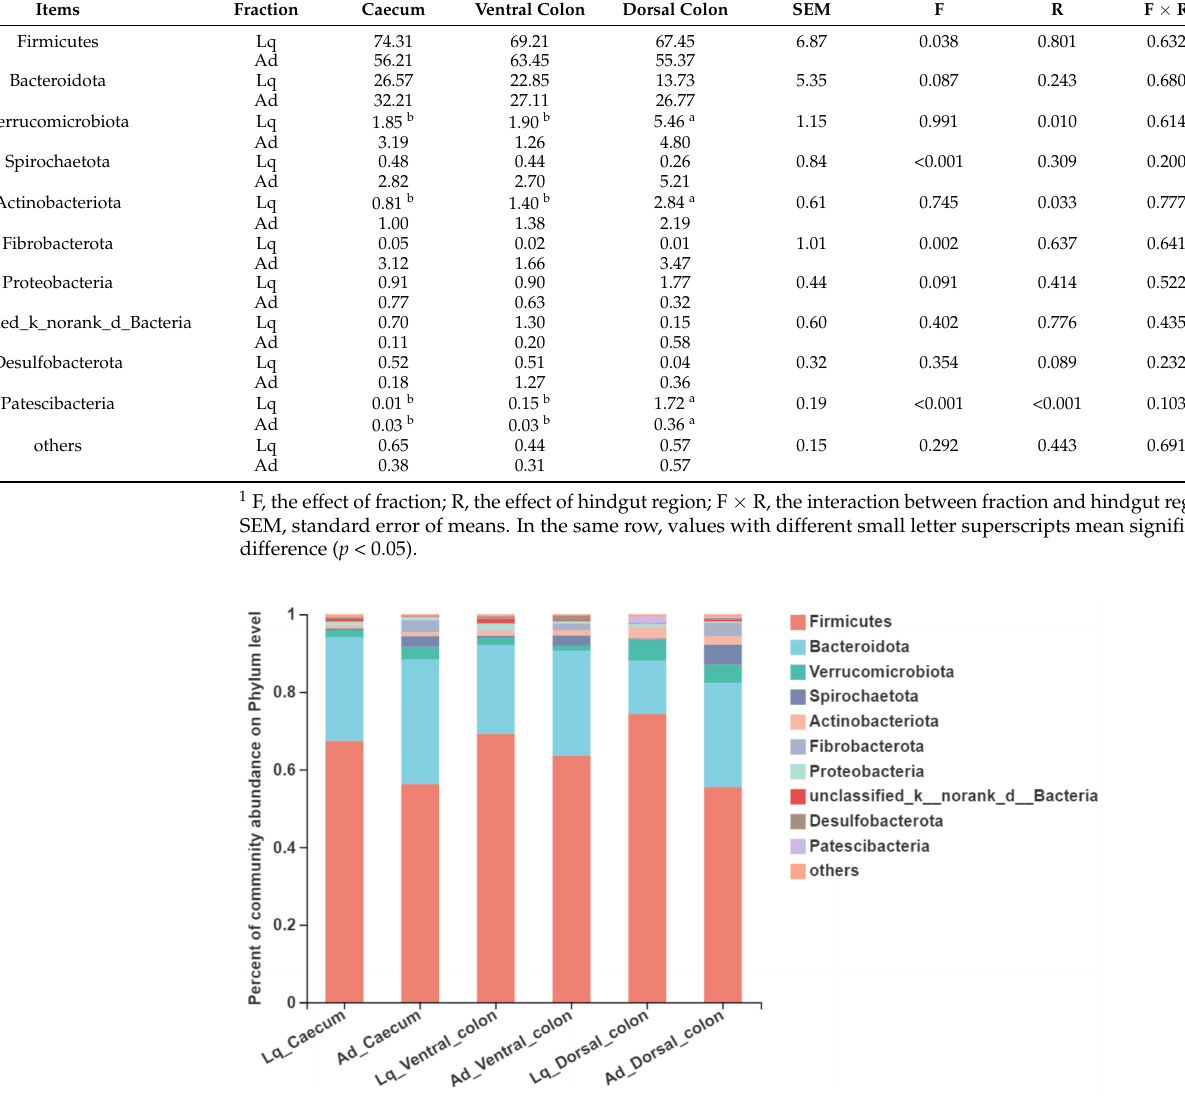
Figure 2. The bacterial community composition at the phylum level in the liquid phase (Lq) and adherent fraction (Ad) within the donkey caeco-colic